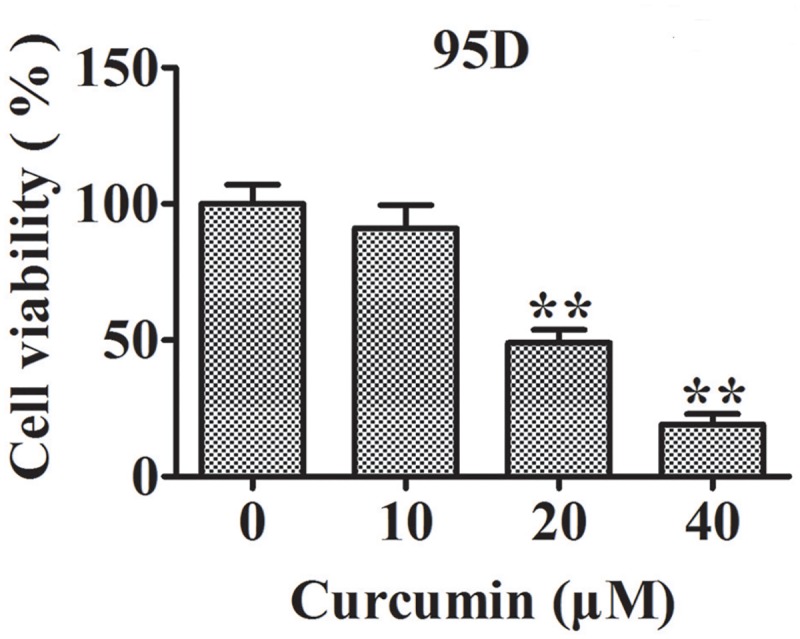
Curcumin inhibits 95D cell proliferation.Columns represent the mean values from three different duplicates and bars stand for standard error. **, p < 0.01 compared with 0 μM curcumin group.